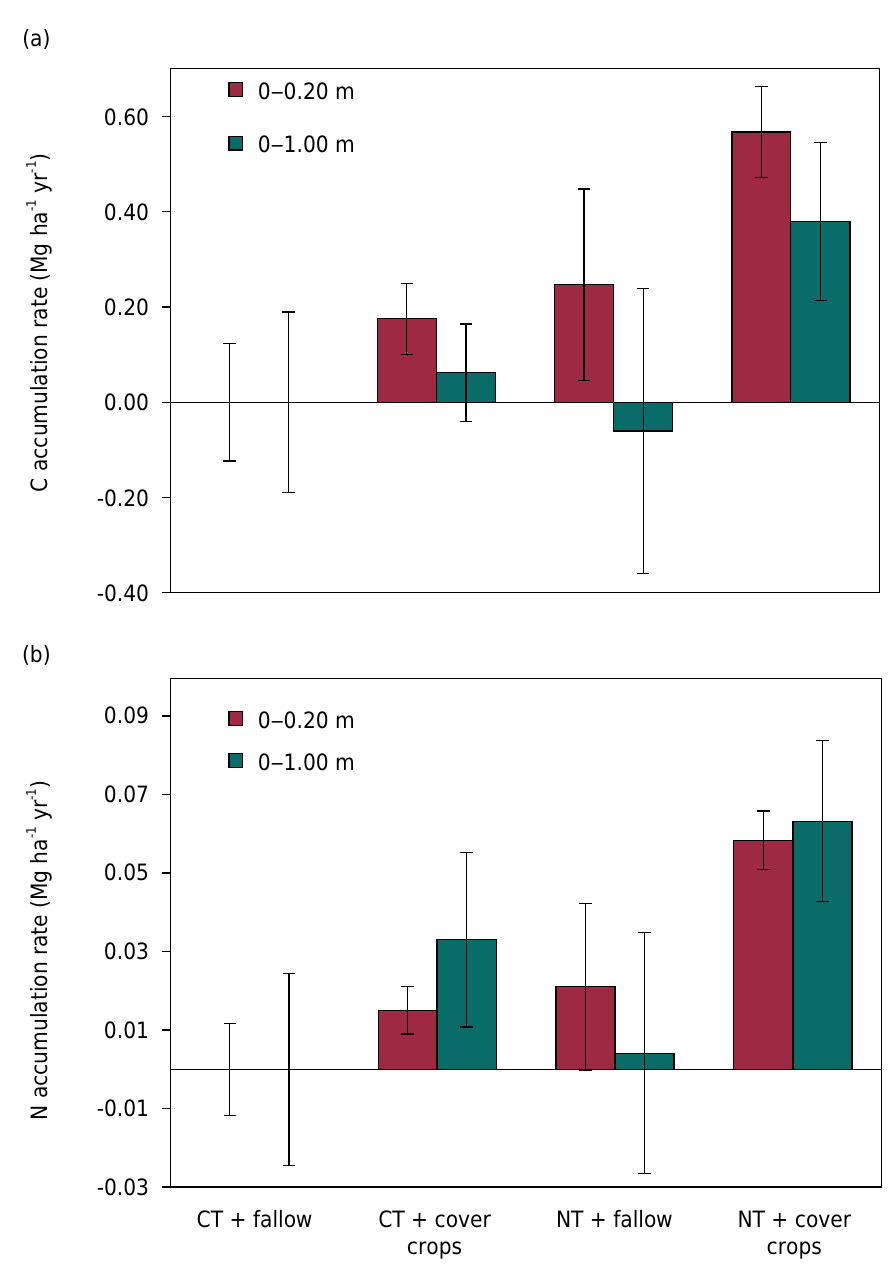
Figure 4. Carbon (a) and nitrogen (b) accumulation rates in the 0‒0.20 and 0‒1.00 m soil layer as affected by soil tillage and winter treatments. NT, no-tillage; CT, conventional